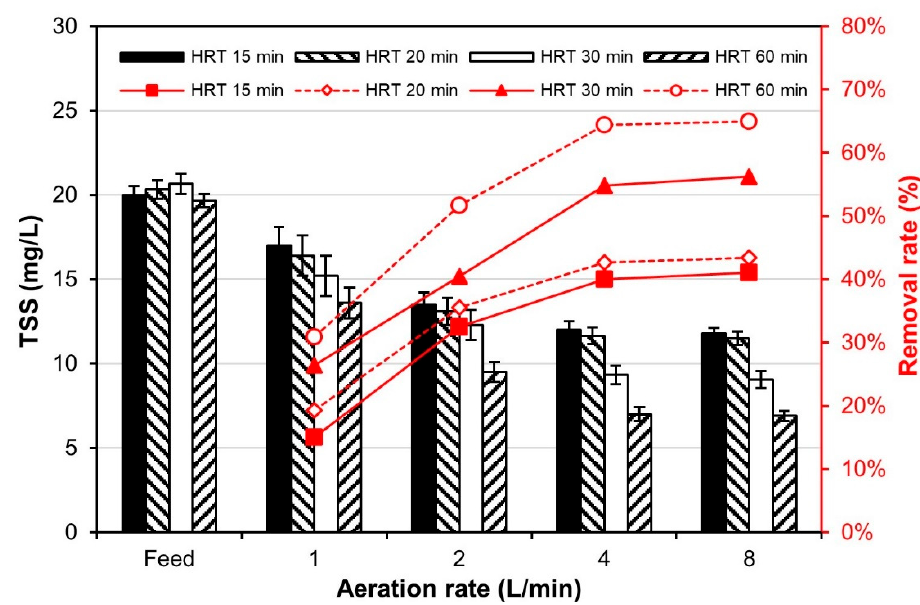
Figure 6. Suspended particle (SP) removal efficiency of the bench-scale MTF reactor as a function of aeration rate.